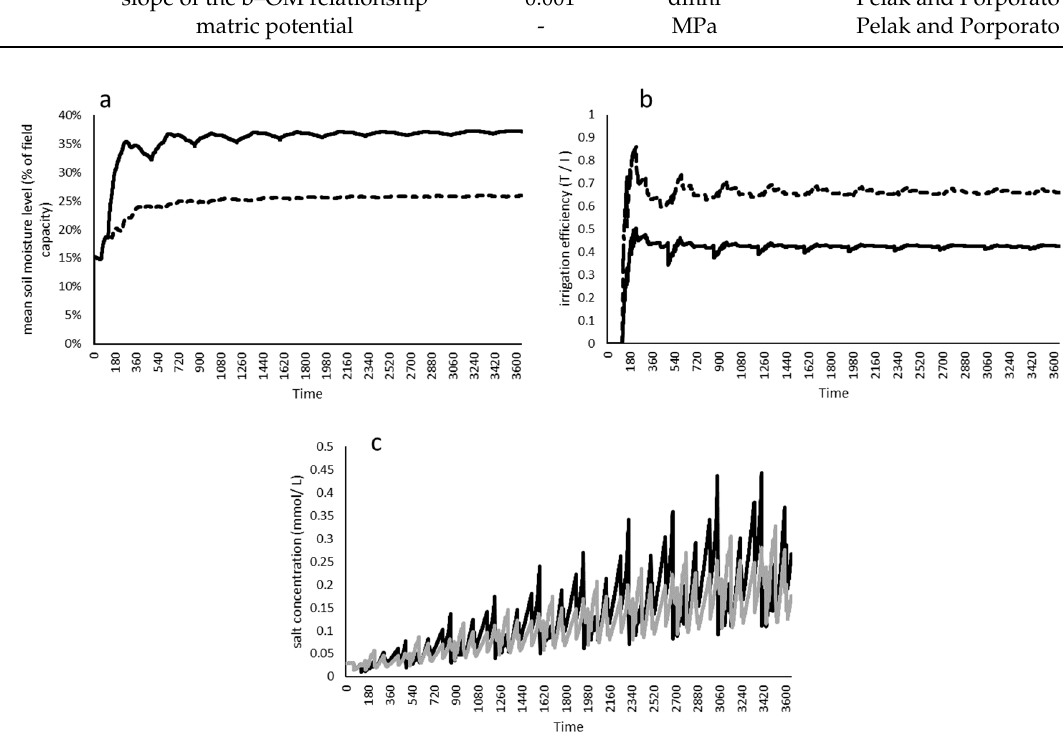
Figure A2. Supplementary biogeochemical results from the tillage test switch from conventional to no-tillage over 10 years (3650 days): (panel a ) salt concentration in soil water under conventional tillage (black) and no-tillage (gray) methods; (panel b ) soil salt level over 10 years under conventional tillage (solid) and no-tillage (dashed line) methods; (panel c ) irrigation efficiency under conventional tillage (solid) and no-tillage (dashed line) methods. References